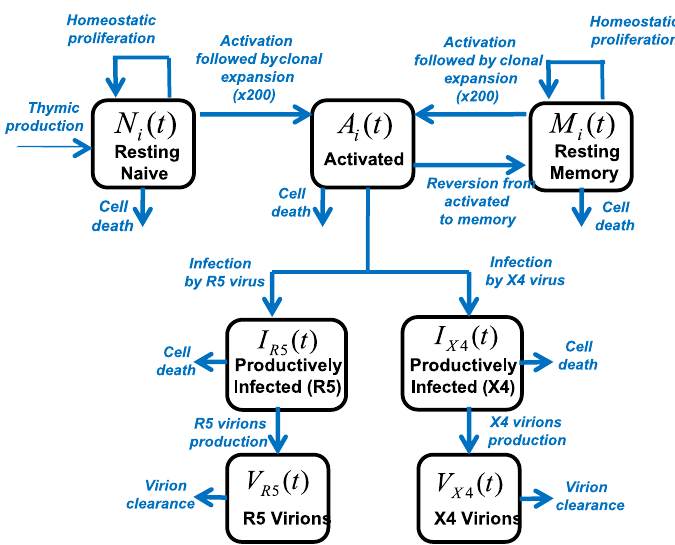
Figure 1. Compartment model of cellular and of viral dynamics. Here N i ( t ) , A i ( t ) and M i ( t ) denote compartments of resting naive, activated and resting memory CD4 + T cells respectively, with i ~ G { ,G z respectively denoting non gene-modified ( i ~ G { ) or gene-modified ( i ~ G z ) CD4 + T cells. G + CD4 + T cells are assumed to contain a dual anti-HIV gene construct (CCR5 entry inhibitor + C46 fusion inhibitor, see Methods). The variables I R 5 ( t ) and I X 4 ( t ) denote compartments of productively infected CD4 + T cells with R5 and 6 4 virus respectively. V R 5 ( t ) and V X 4 ( t ) respectively denote compartments of R5 and 6 4 virions.